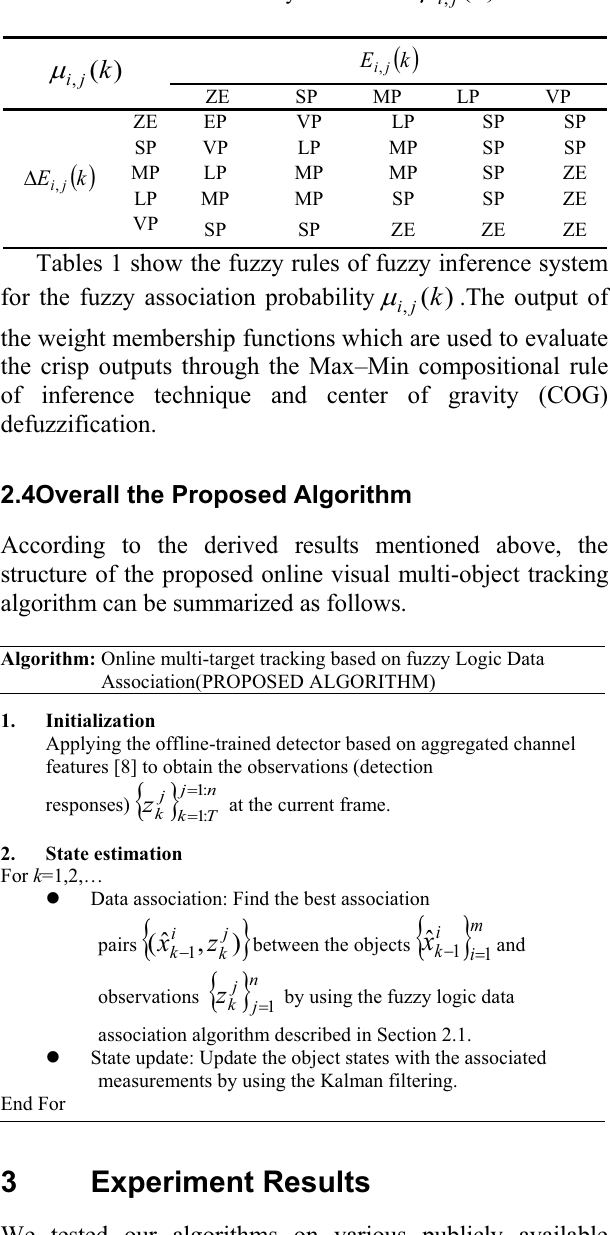
TABLE I. Fuzzy rule base for